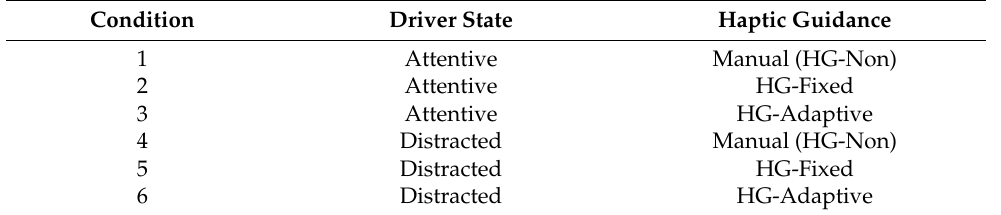
Table 1. Experimental